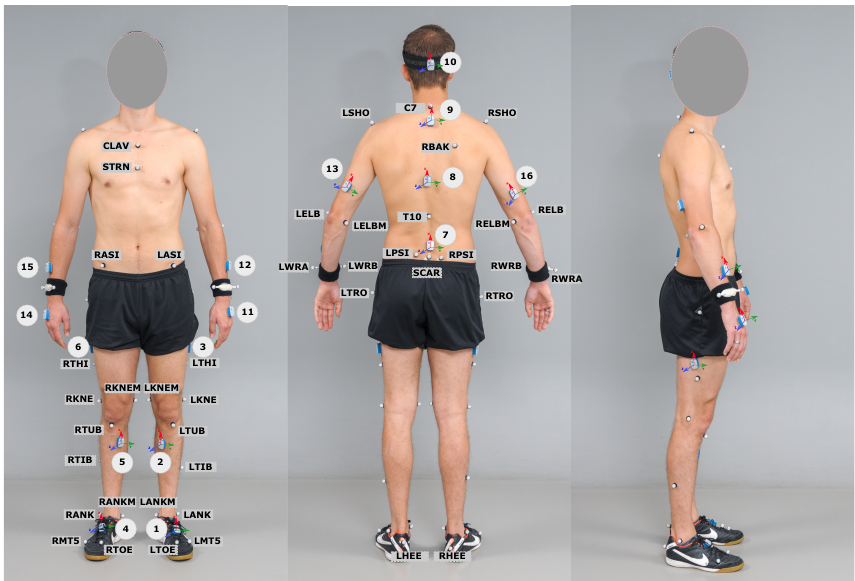
Figure 1. Placement of IMUs and marker placement of the plug-in gait model. A total of 42 reflective markers are placed on bony landmarks of participants, and 16 IMUs are placed based on proposed instructions of the manufacturer. In this study, IMUs 1–7 were used for analysis. Table 2. Description of IMUs placements. Sensor Position